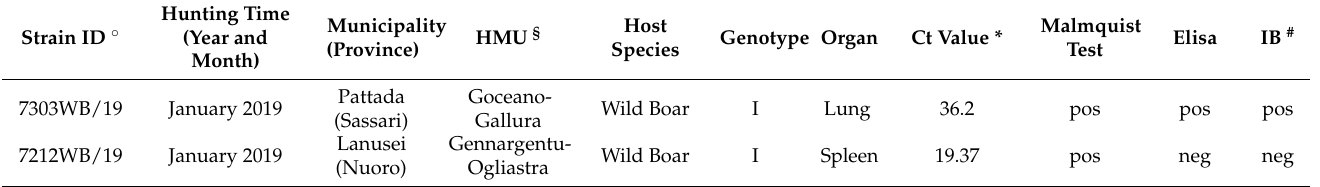
Table 1. ASF virus strains isolated from wild boar hunted in Sardinia during January 2019. Results of both virological (tested organs, Ct values of real-time PCR, and Malmquist test) and serological (ELISA and immunoblotting) tests are